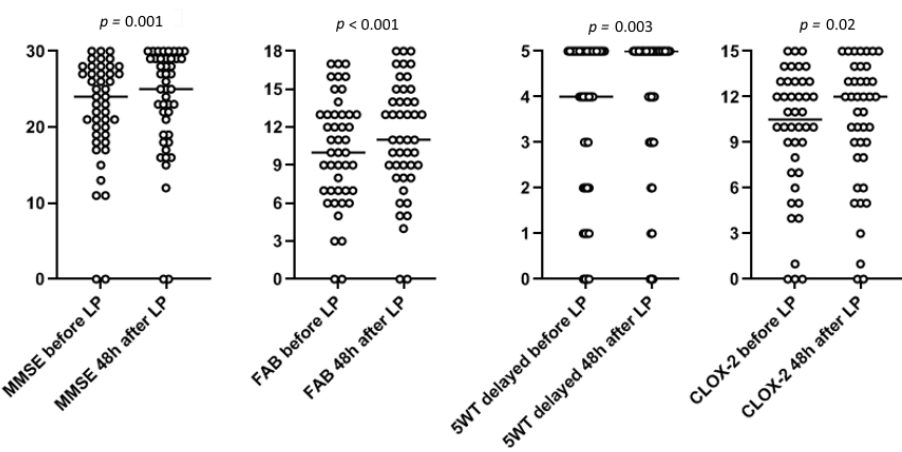
Figure 2. Change in the individual neuropsychological test scores for the whole group of patients before and 48 h after lumbar puncture. The horizontal bars represent median values of MMSE, FAB, 5-word test delayed recall and CLOX-2, respectively.